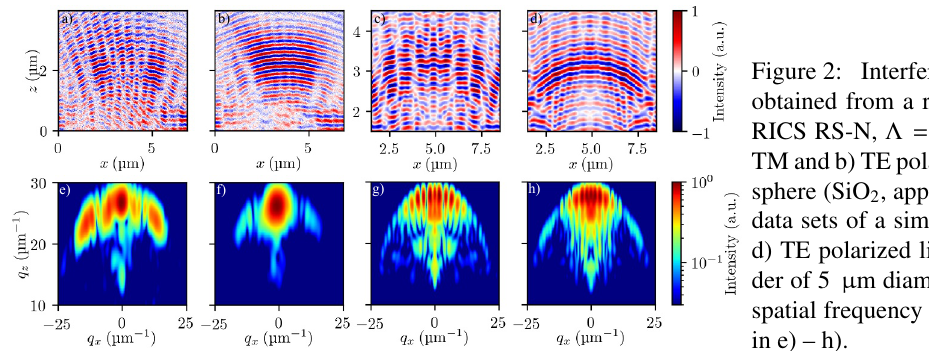
Figure 2: Interferometric measurement data obtained from a rectangular grating (SiMET- RICS RS-N, Λ = 300 nm) using royalblue a) TM and b) TE polarized light through a micro- sphere (SiO 2 , approx. 7 µ m diam.), simulated data sets of a similar grating with c) TM and d) TE polarized light assuming a microcylin- der of 5 µ m diameter. The corresponding 3D spatial frequency representations are depicted in e) –